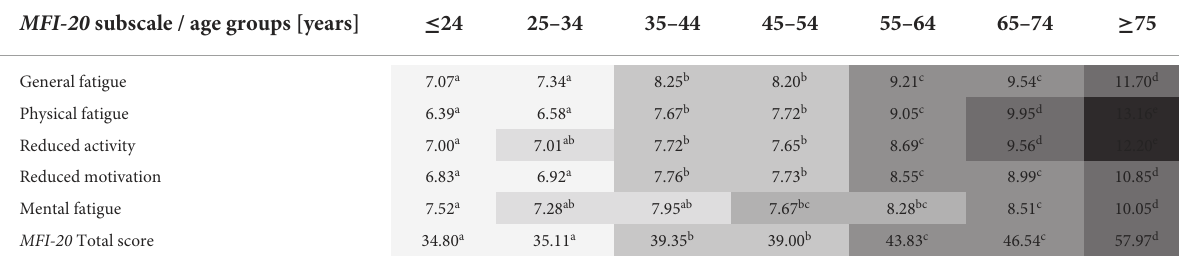
UpperrightvaluesshowPearson’scorrelations.Lowerleftvalues( p )showpartialcorrelations(controlledforage). All correlations are significant(p < 0.001), using Spearman’s ρ , also significantresults with Kendall’s τ and Pearson’s correlations. The highestcorrelation betweenthe MFI-20 scores and theSF-36domainsareprintedinbold.SF-36,ShortForm(36)HealthSurvey;PCS,PhysicalComponentScale;MCS,MentalComponentScale. TABLE 4 Results of the Kruskal-Wallis Dunn-Bonferroni post-hoc tests for the MFI-20 subscales and the total score, by age groups, shown in the superscript table. MFI-20 subscale / age groups